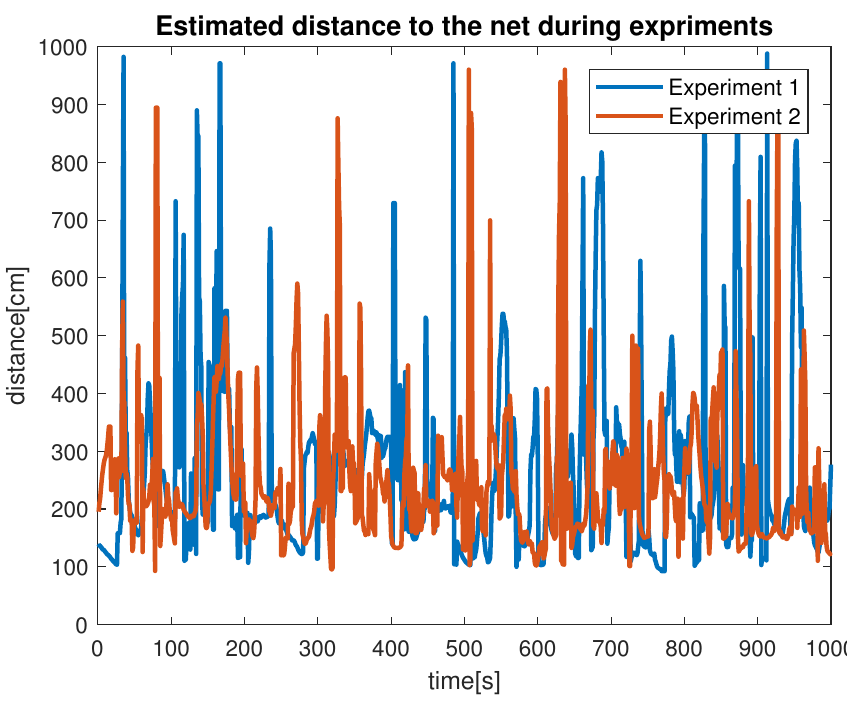
Figure 20. Fish cage net distance estimation.